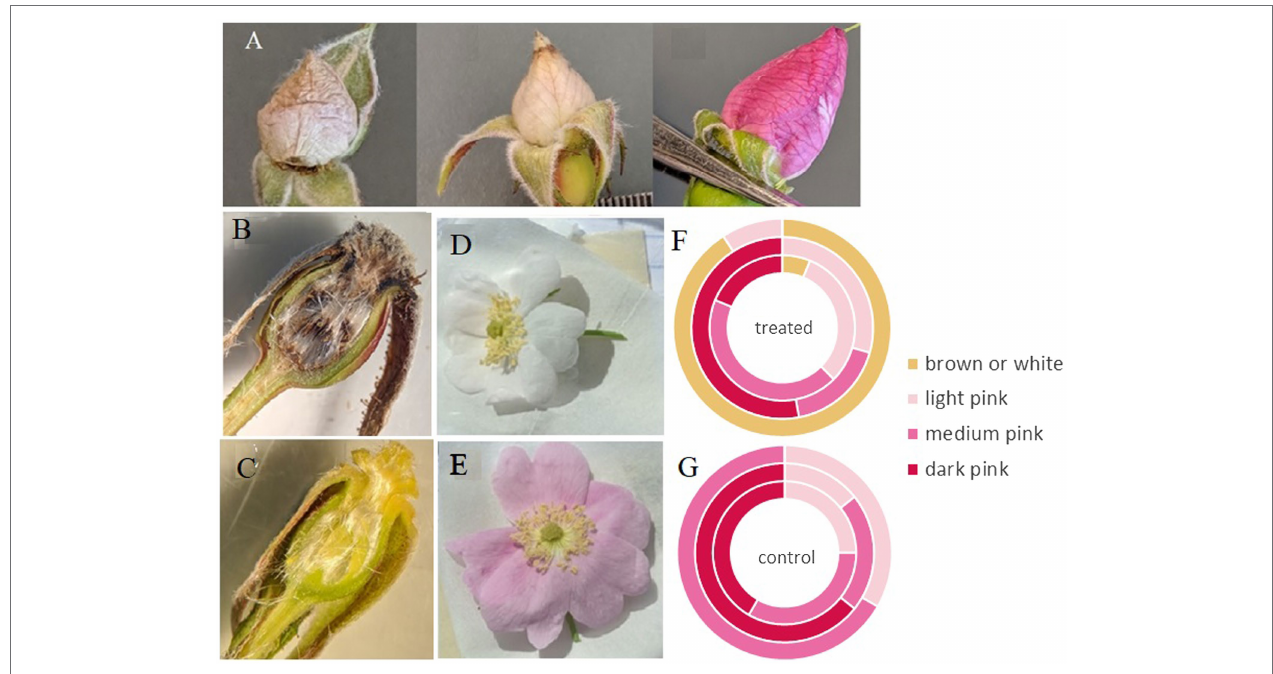
FIGURE 2 | Buds and flowers of Rosa acicularis plants. (A) The range of variation in bud color and condition of those collected from operational forestry cutblocks treated with GBH one-year post-treatment. (B) View of inside the hypanthium in treated flowers, and (C) control flowers. (D,E) Flower color from a controlled experiment, 25% of flowers treated with GBH at 0.45 kg a.i./ha, showed white petals (D) , while all controls remained pink (E) . (F,G) Variation in flower color assessed in treated (F) and control groups (G) in operational forestry cutblocks sampled (outer ring = Hoodoo site, middle ring = Kaykay site, and inner ring = Bobtail